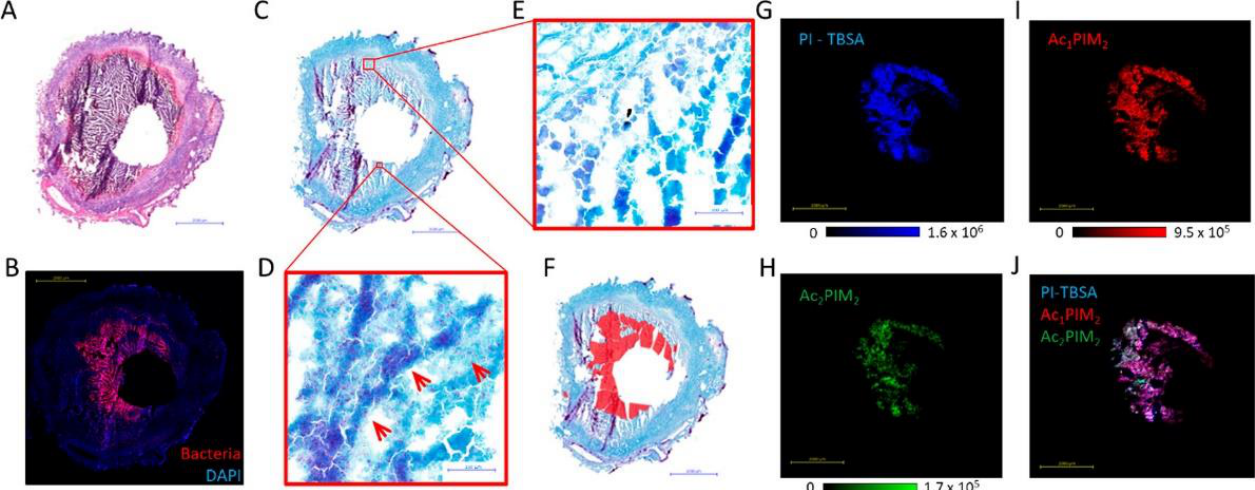
Figure 7. MALDI-MSI of phosphatidylinositol mannosides distributions within rabbit caseous- granuloma sections, matching Mycobacterium grouping. Figure was reproduced from Blanc and col- leagues’ work